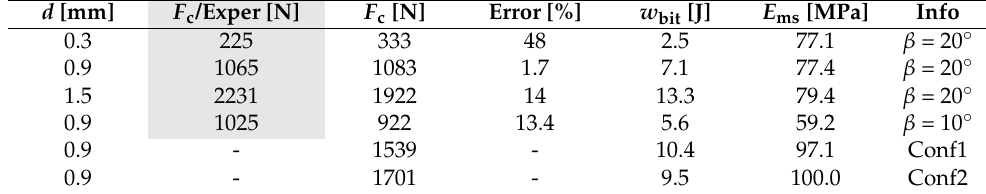
Table 2. Simulation results compared to experiments in [4] (gray